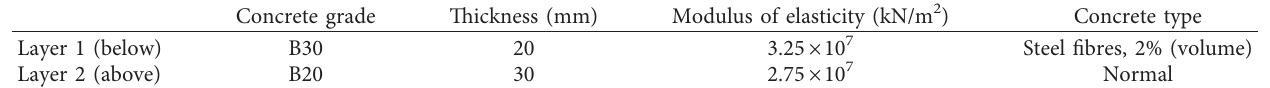
Table 1: Geometric and material parameters of concrete shell.